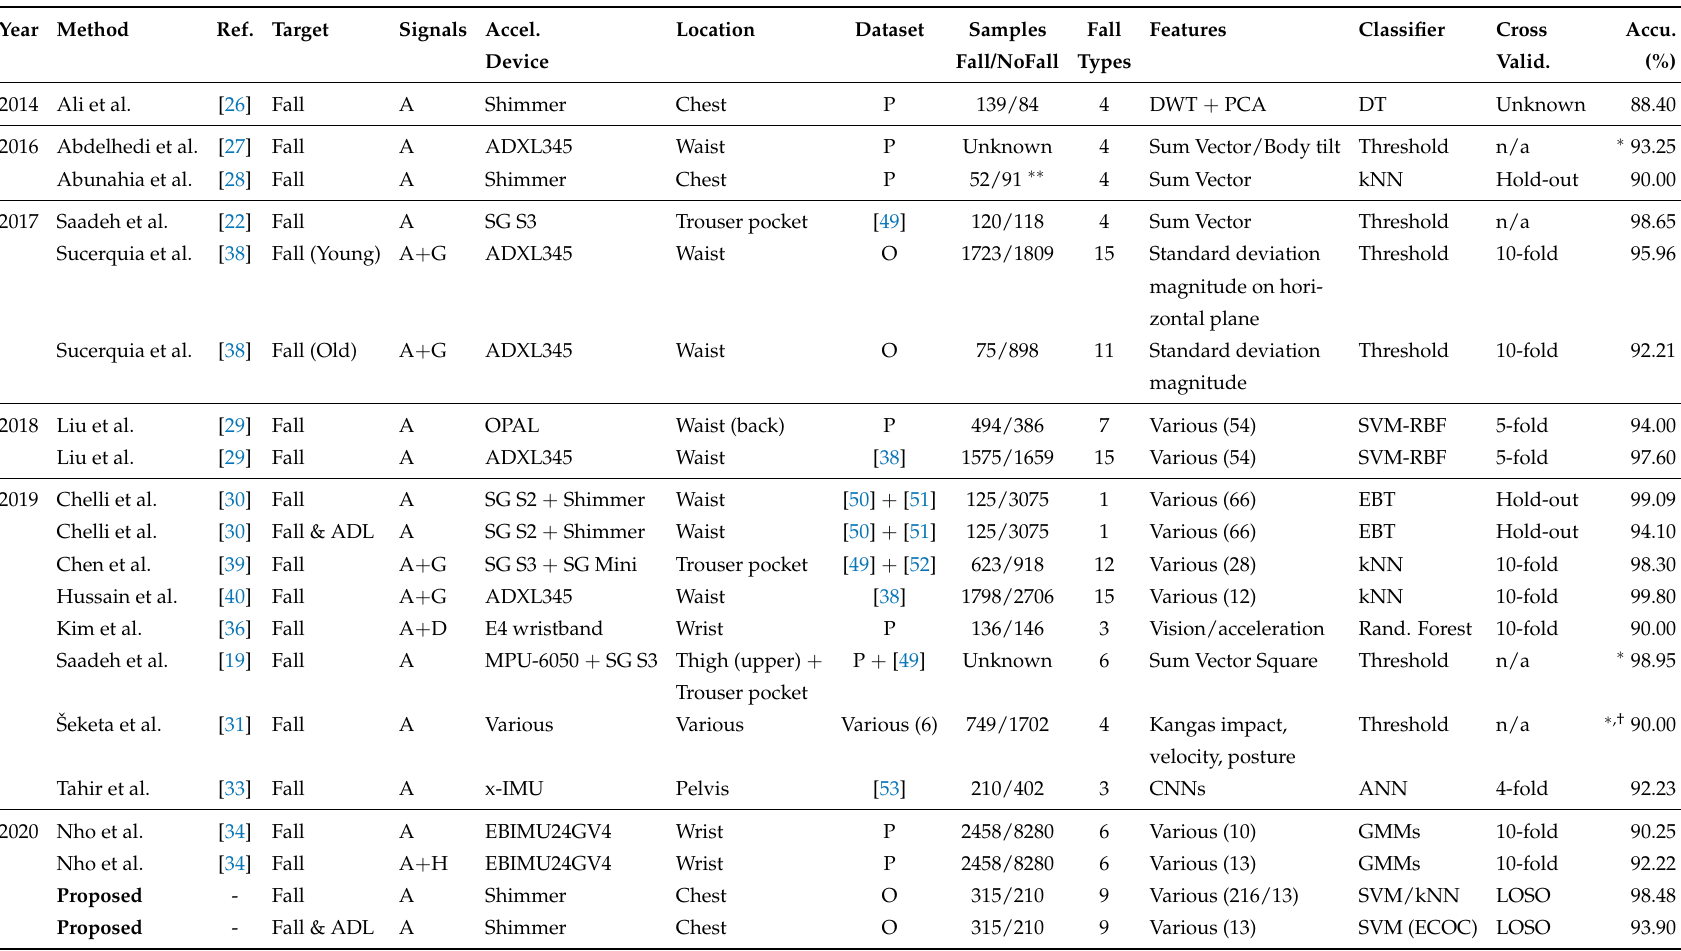
Table 5. Accuracy (%) of various accelerometer-based state-of-the-art fall detection methods, as reported in the literature, in ascending chronological